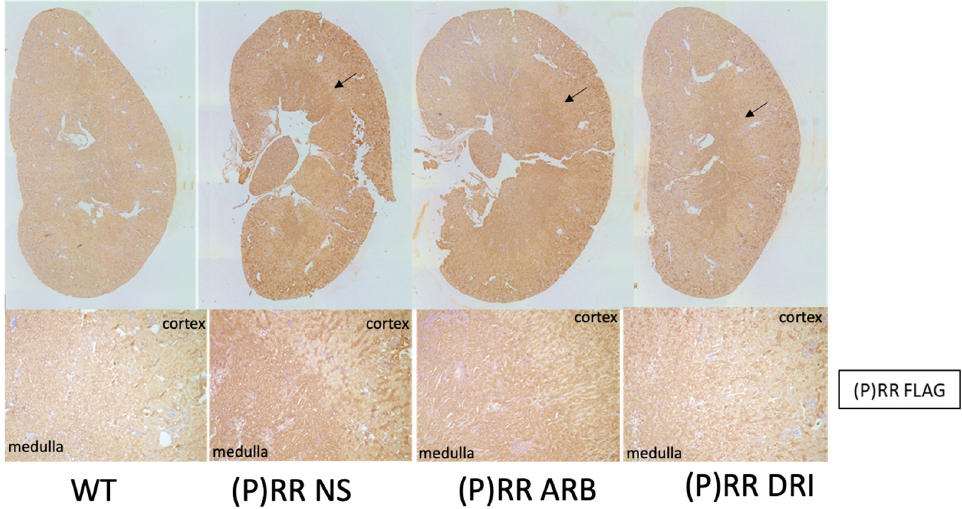
Figure 2. Representative histopathological findings using immunohistochemistry with anti-FLAG antibody (monoclonal ANTI-FLAG M2, Clone M2, SIGMA-ALDRICH ® , Tokyo, Japan) are shown. Arrows indicate positive staining in lower magnification ( above ) and in higher magnification (X100, below ). These findings were shown as WT, (P)RR-TG, (P)RR-TG+ARB, and (P)RR-TG+DRI, respec- tively.